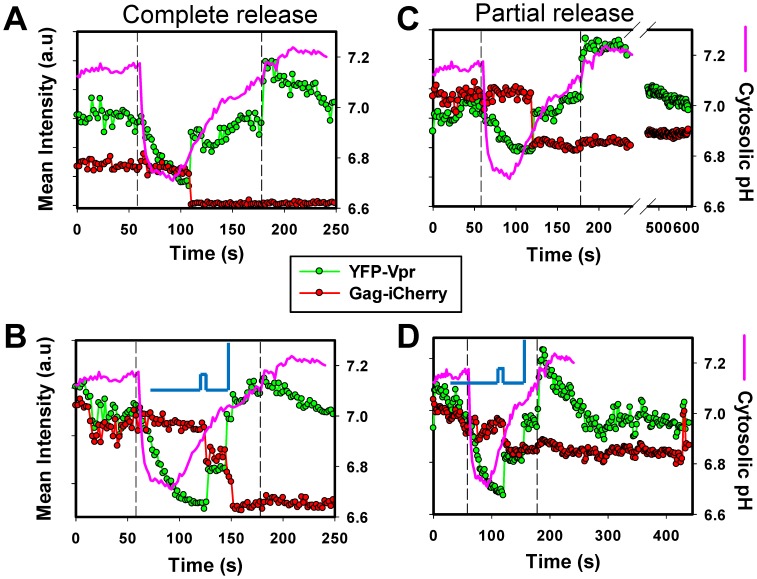
Temporal correlation between YFP dequenching and complete and partial release of iCherry upon synchronized ASLV-A pseudovirus fusion.ASLV-A fusion was arrested with NH4Cl and synchronously triggered by removing the weak base. (A) ASLV-A fusion results in complete release of iCherry and biphasic recovery of the YFP signal during HBSS perfusion. (B) Transient closure of a fusion pore followed by a complete loss of iCherry and recovery of the YFP signal. Pore closure was manifested in transient cessation of the drop in iCherry fluorescence and of YFP dequenching, which resumed upon pore reopening. (C) ASLV-A fusion leading to a partial release of iCherry. (D) Transient pore closure with partial release of content. The steady iCherry signal following the partial release events shown in panels B and D shows the lack of post-fusion content release. The slowly decreasing YFP signal after fusion could reflect the YFP-Vpr dissociation from the viral core. Vertical dashed lines indicate the onset and the end of HBSS perfusion. Blue lines in panels B and D illustrate the predicted profiles of flickering fusion pores.